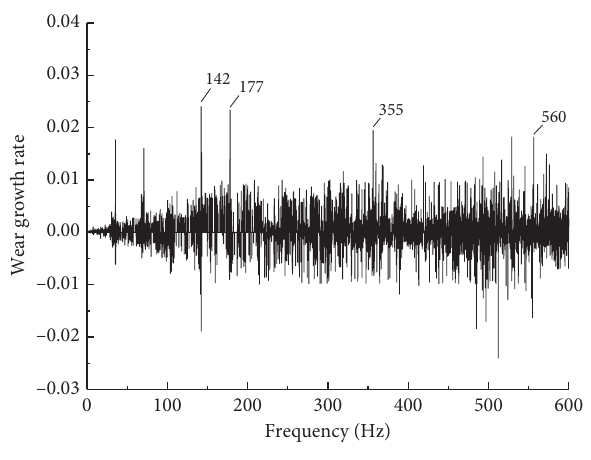
Figure 17: Wear growth rate.